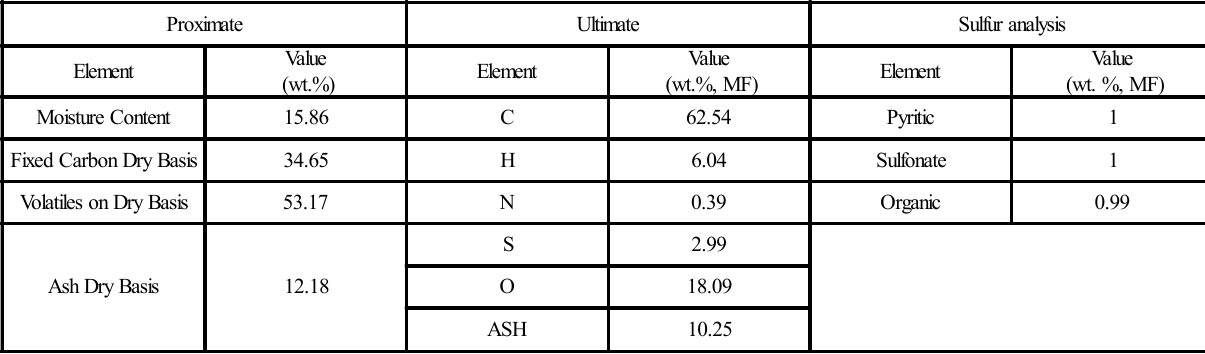
TABLE 4. PROPERTIES OF THAR (AIR DRY BASIS) OF LAKHRA COAL FIELD [18]